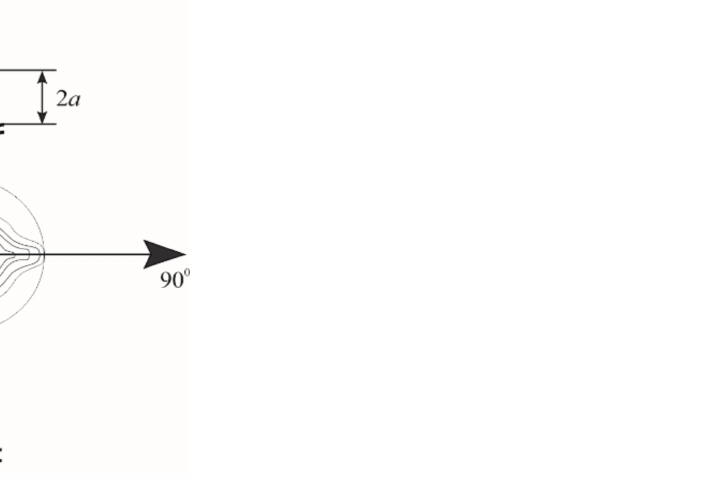
Figure 1. Schematic diagram of a separate row of arranging parallel fibres (calculation section): a—fibre radius, m; b—distance between the axes of the adjacent cylinders, m; r , θ —polar coordinates; U —air velocity